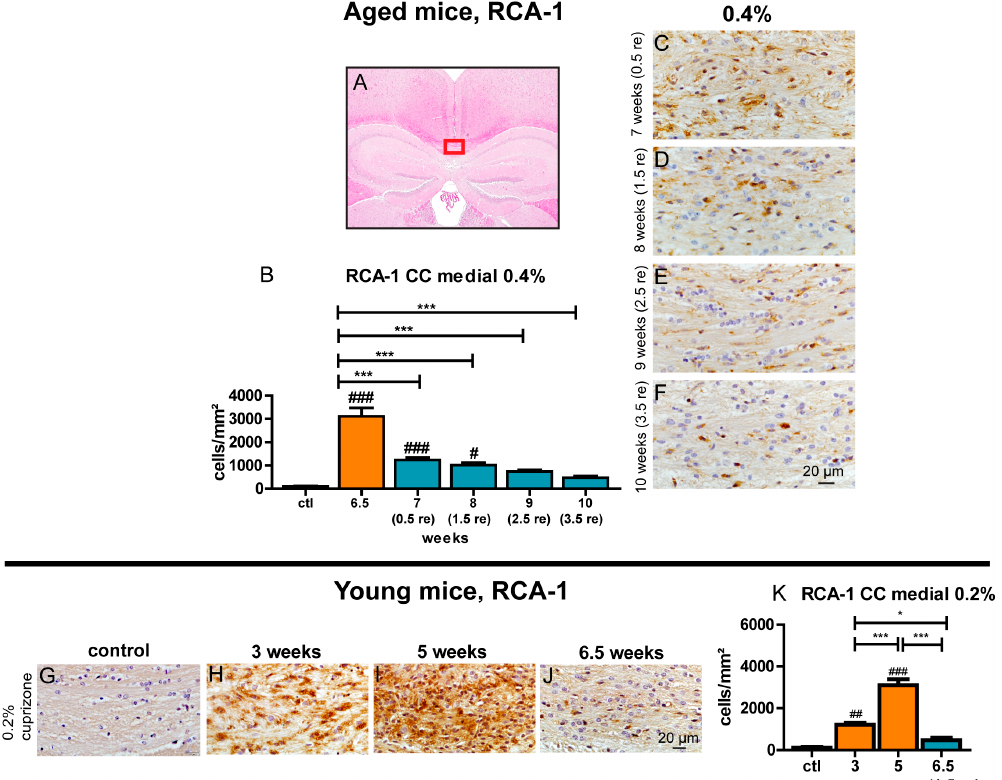
Figure 7. Delayed decrease of activated microglia during the course of remyelination in the medial corpus callosum of aged mice. The medial part of the corpus callosum that was analyzed is highlighted ( A ). Graphs show the amount of RCA-1-positive activated microglia / mm 2 for the respective time points of demyelination and subsequent remyelination in aged mice treated with 0.4% cuprizone for 6.5 weeks ( B ) and young mice fed with 0.2% cuprizone for 5 weeks ( K ). See Figure 3 for representative images of RCA-1 staining of aged mice for controls and demyelination after 0.4% cuprizone feeding for 6.5 weeks, respectively. Representative sections show the decrease of activated microglia populations during the course of remyelination in the central corpus callosum of aged mice ( C – F ) and the increase of activated microglia during demyelination in young mice plus a decrease during subsequent remyelination ( G – J ). Bars show mean + SEM. Significant e ff ects between di ff erent investigated time points are indicated by asterisks and e ff ects in comparison to control are indicated by hashmarks (* / # p < 0.05; ** / ## p < 0.01; *** / ### p < 0.001). Ctl. = control; 6.5 weeks = feeding period of 0.4% cuprizone in aged mice; 7 (0.5 re) weeks = 0.5 weeks of remyelination, 8 (1.5 re) weeks = 1.5 weeks of remyelination, 9 (2.5 re) weeks = 2.5 weeks of remyelination, 10 (3.5 re) weeks = 3.5 weeks of remyelination in aged mice; 3 and 5 weeks = feeding period of 0.2% cuprizone in young mice; 6.5 (1.5) weeks = 1.5 weeks of